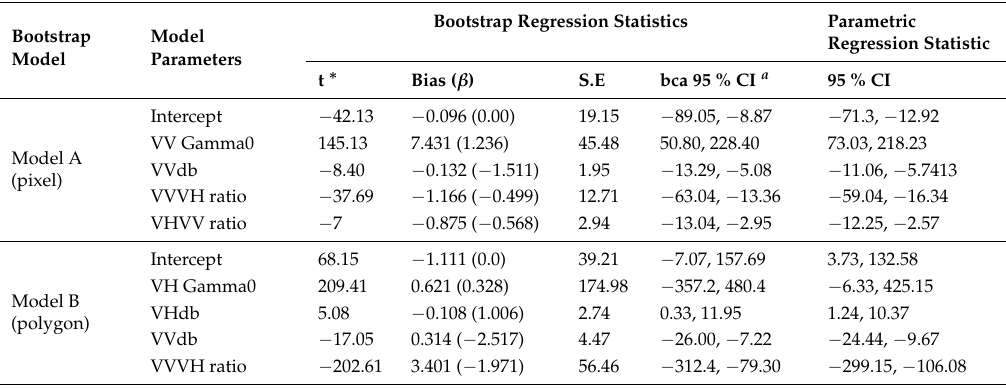
Table 5. Summary statistics for the bootstrap regression models of canopy gap fraction ( ∗ the estimate of coefficient based on 1000 bootstrap samples, and a the 95 % confidence intervals based on the bias corrected and accelerated calculations).